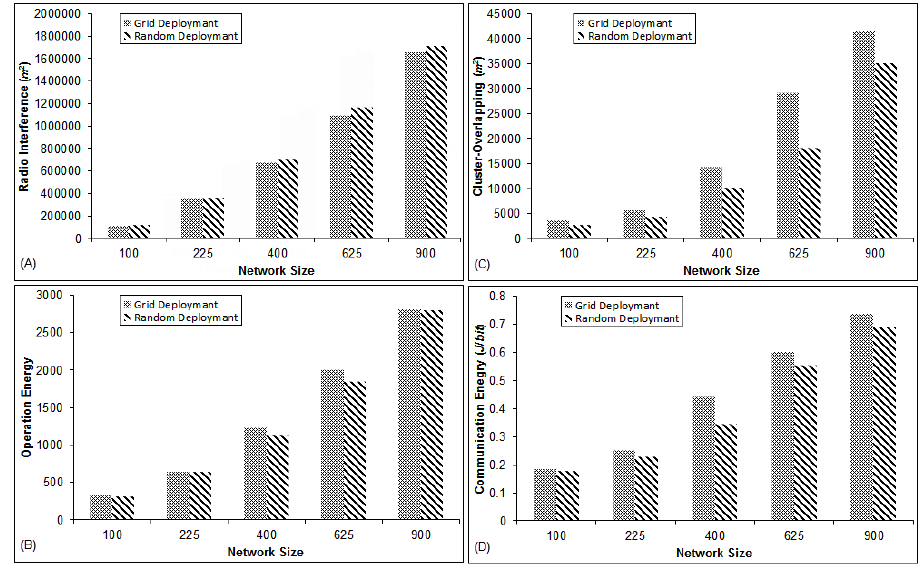
Figure 6. Radio interference (A), operation energy (B), cluster-overlapping(C), and communication energy (D) versus network sizes under grid and random deployments.